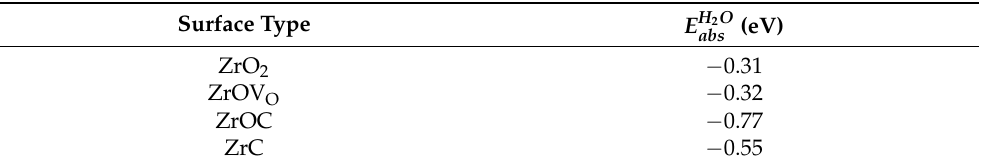
Table 3. Values of absorption energy of water molecule on the ( − 111) surface of ZrO 2 , ZrO 2 ( − 111) surface with an oxygen vacancy (ZrOV O ), ZrO2 ( − 111) surface with oxygen vacancy occupied by carbon (ZrOC), and the ZrC (111)